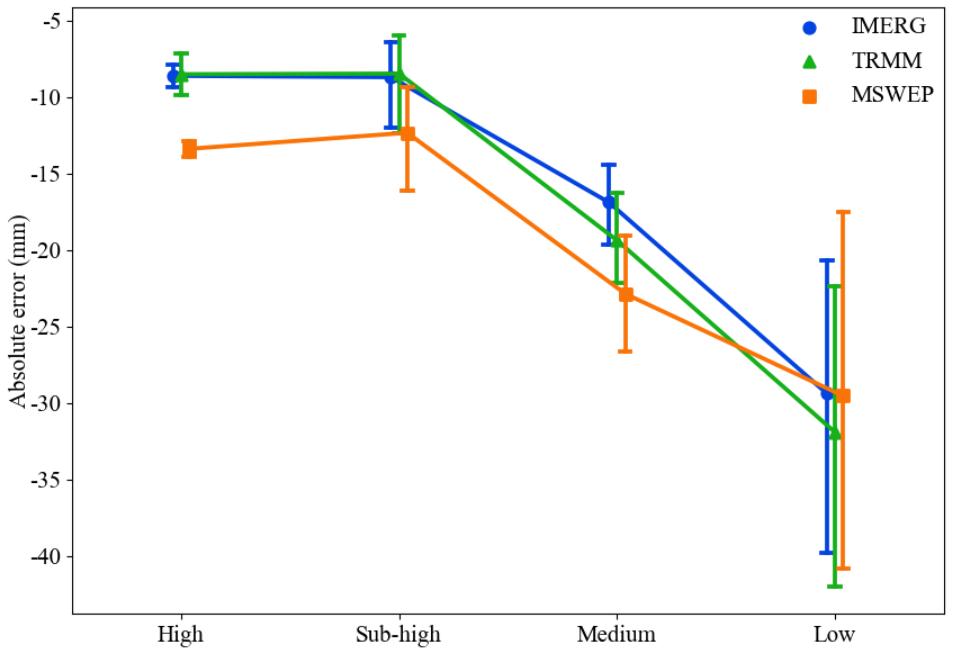
Figure 10. Absolute error between precipitation products and observed data on the altitude gradient at Max99.